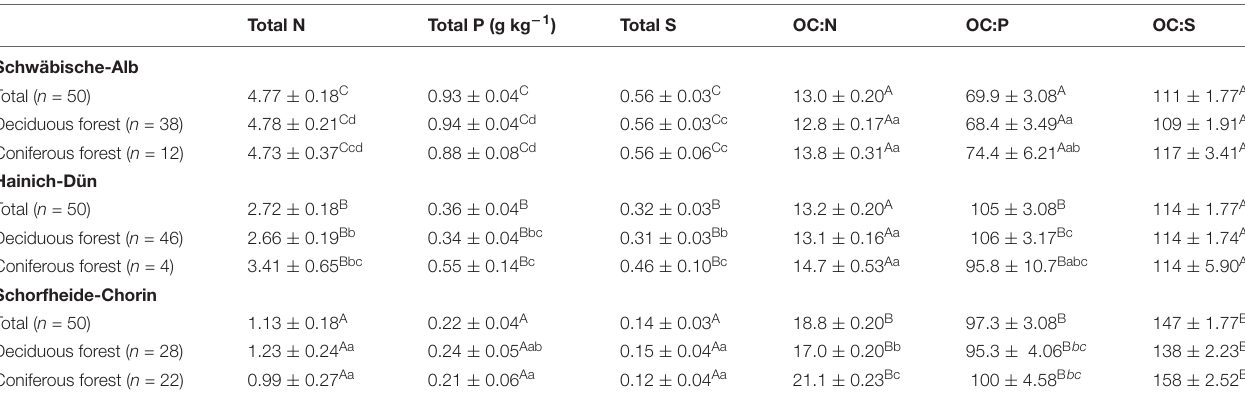
TABLE 2 | Mean values of soil total N, P, and S concentrations and OC:N, OC:P, and OC:S ratios under different study regions and managements (mean ±